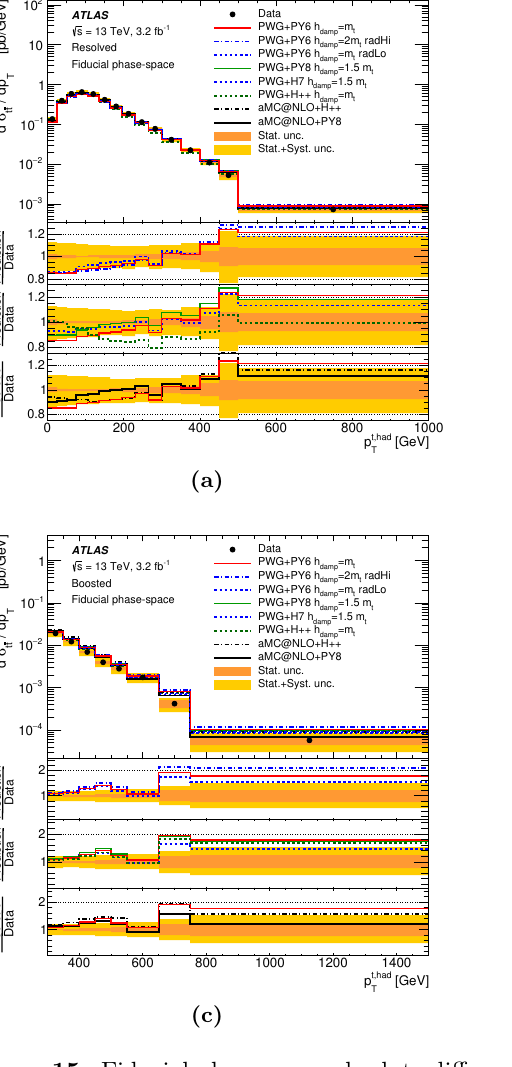
Figure 15. Fiducial phase-space absolute di(cid:11)erential cross-sections as a function of the (a) trans- (cid:12) (cid:12) verse momentum ( p t; had ) and (b) the absolute value of the rapidity ( (cid:12) y t; had (cid:12) ) of the hadronic top T quark in the resolved topology and corresponding results in the boosted topology (c), (d). The yellow bands indicate the total uncertainty of the data in each bin. The Powheg + Pythia6 generator with h damp = m t and the CT10 PDF is used as the nominal prediction to correct for detector e(cid:11)ects. The lower three panels show the ratio of the predictions to the data. The (cid:12)rst panel compares the three Powheg + Pythia6 samples with di(cid:11)erent settings for additional radiation, the second panel compares the nominal Powheg + Pythia6 sample with the other Powheg samples and the third panel compares the nominal Powheg + Pythia6 sample with the MadGraph5 a MC@NLO